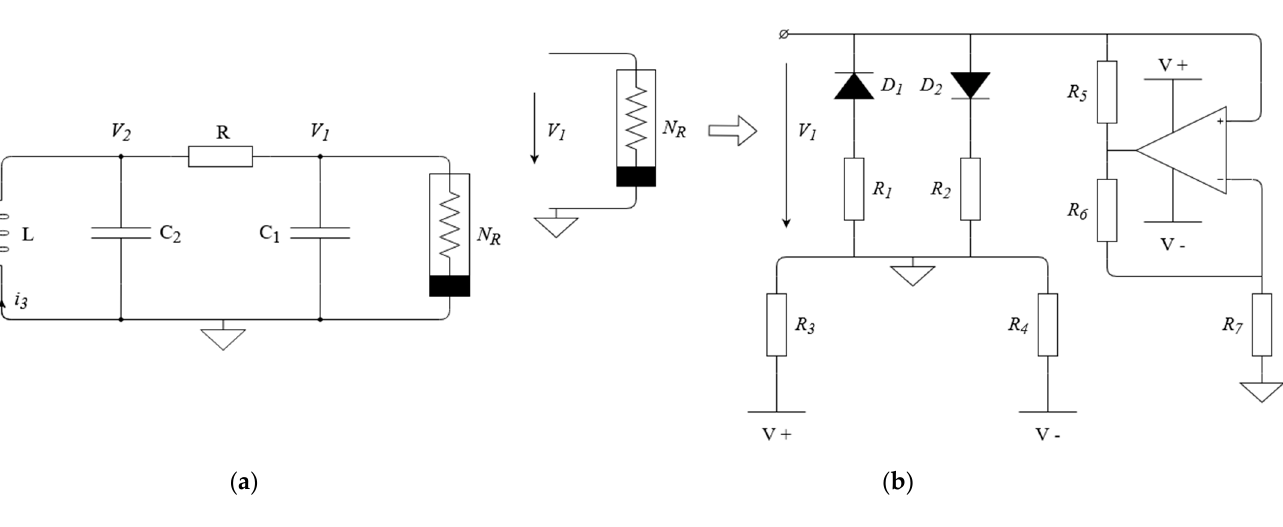
Figure 4. Chua’s chaos oscillator circuit ( a ). Chua’s nonlinear resistor circuit ( b ), where R = 1.6 k Ω , C 1 = 4.7 nF, C 2 = 47 nF, L = 8.5 mH, R 1 = 3.3 k Ω , R 2 = 3.3 k Ω , R 3 = 47 k Ω , R 4 = 47 k Ω , R 5 = 290 Ω , R 6 = C 1 = 4.7 nF, C 2 = 47 nF, L = 8.5 mH, R 1 = 3.3 k Ω , R 2 = 3.3 k Ω , R 3 = 47 k Ω , R 4 = 47 k Ω , R 5 = 290 Ω , 290 Ω , R 7 = 1.2 k Ω . Silicon diode 1N4148 as D 1 and D 2 and OP AMP LT1351 are used. R 6 = 290 Ω , R 7 = 1.2 k Ω . Silicon diode 1N4148 as D 1 and D 2 and OP AMP LT1351 are